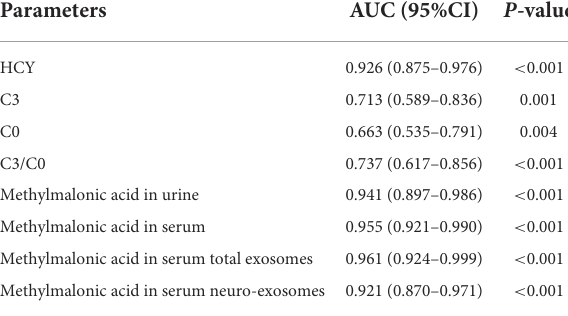
TABLE 4 The performance of biomarkers in distinguish between normal children and cognitive impairment induced by